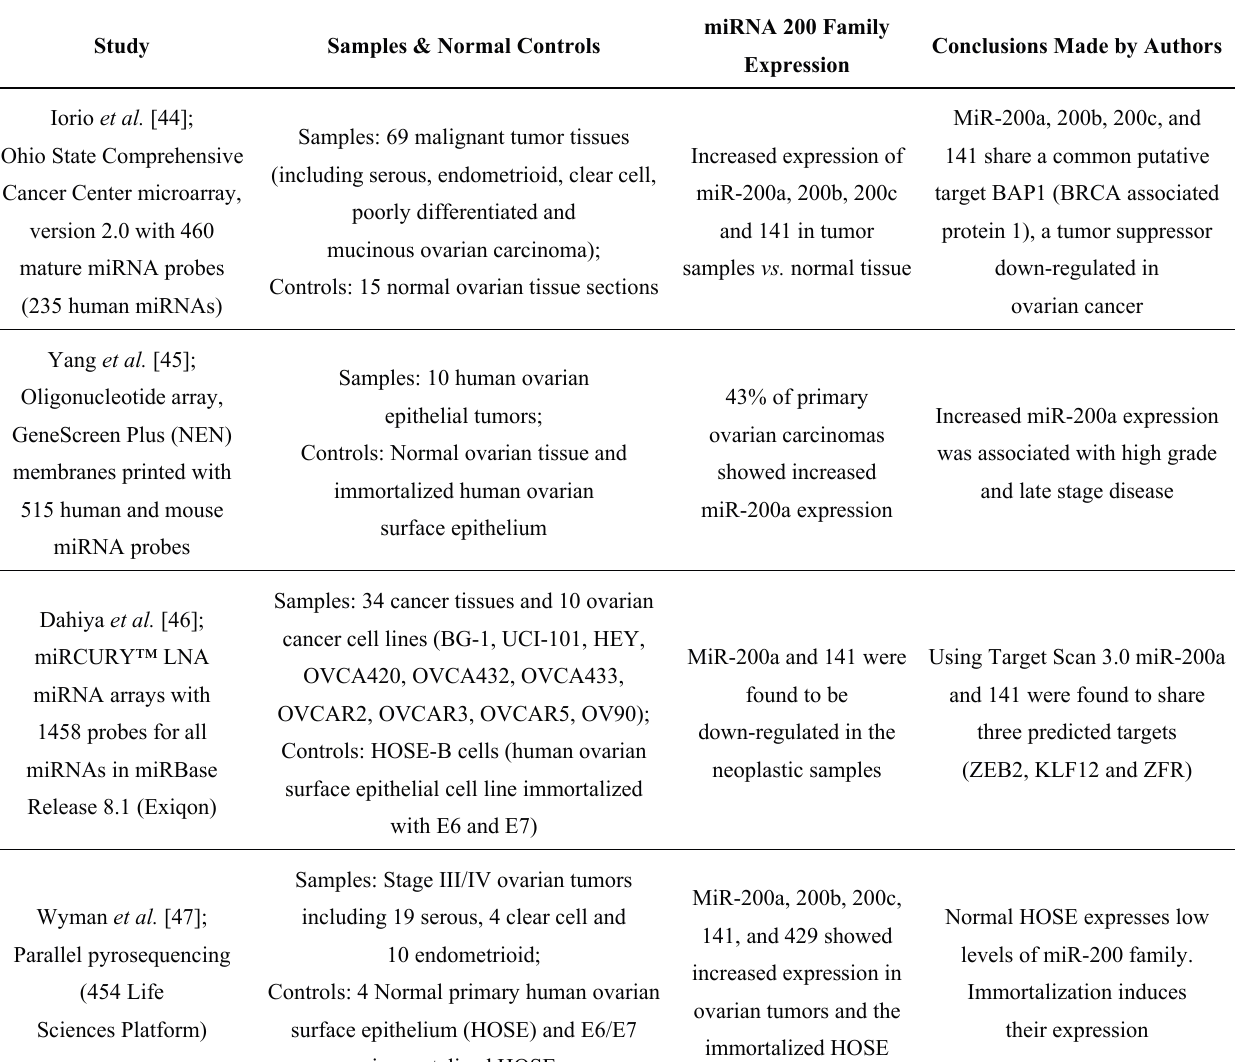
Table 1. miRNA 200 family expression in ovarian cancer profiling